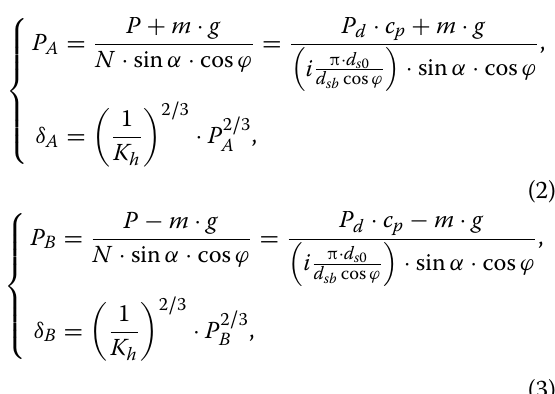
where d s0 and d sb are the diameters of the screw and ball, respectively. α is the contact angle between the ball and the raceway. φ is the pitch angle of the screw. i is the number of rings in a single nut. d s0 and d sb are the diameters of the screw shaft and ball, respectively. N is the number of balls in a single nut. P d is the rated dynamic load of the screw-nut joints. P is the preload of nut A and nut B. P A and P B are the initial normal forces in a single ball of nut A and nut B, respectively. c p is the rated dynamic load factor. δ A and δ B are the normal deformations of a ball in nuts A and B, respectively. K h is the Hertz contact coefficient, which mainly depends on